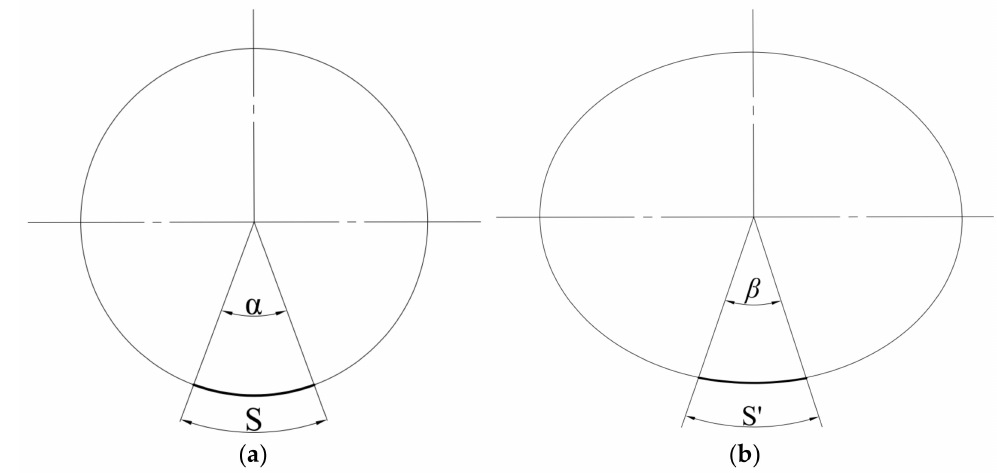
Figure 2. Determination of crack angle in finite element model. ( a ) Circumferential crack section ( θ = 0 ◦ ) ( b ) Inclined crack section ( θ (cid:54) = 0 ◦